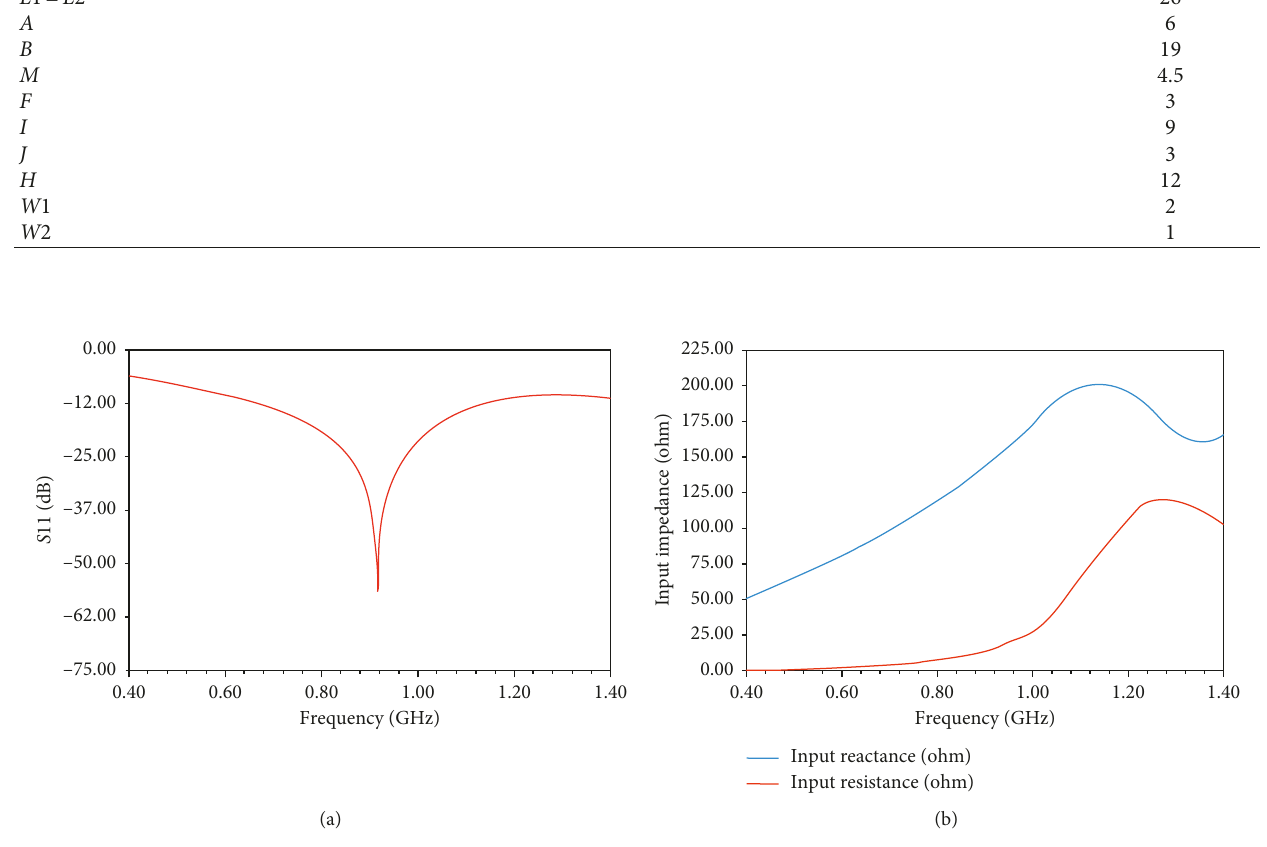
Figure 5: Simulated reflection coefficient S 11 (a) and antenna input impedance (b) of the first proposed epidermal tag attached to the human torso